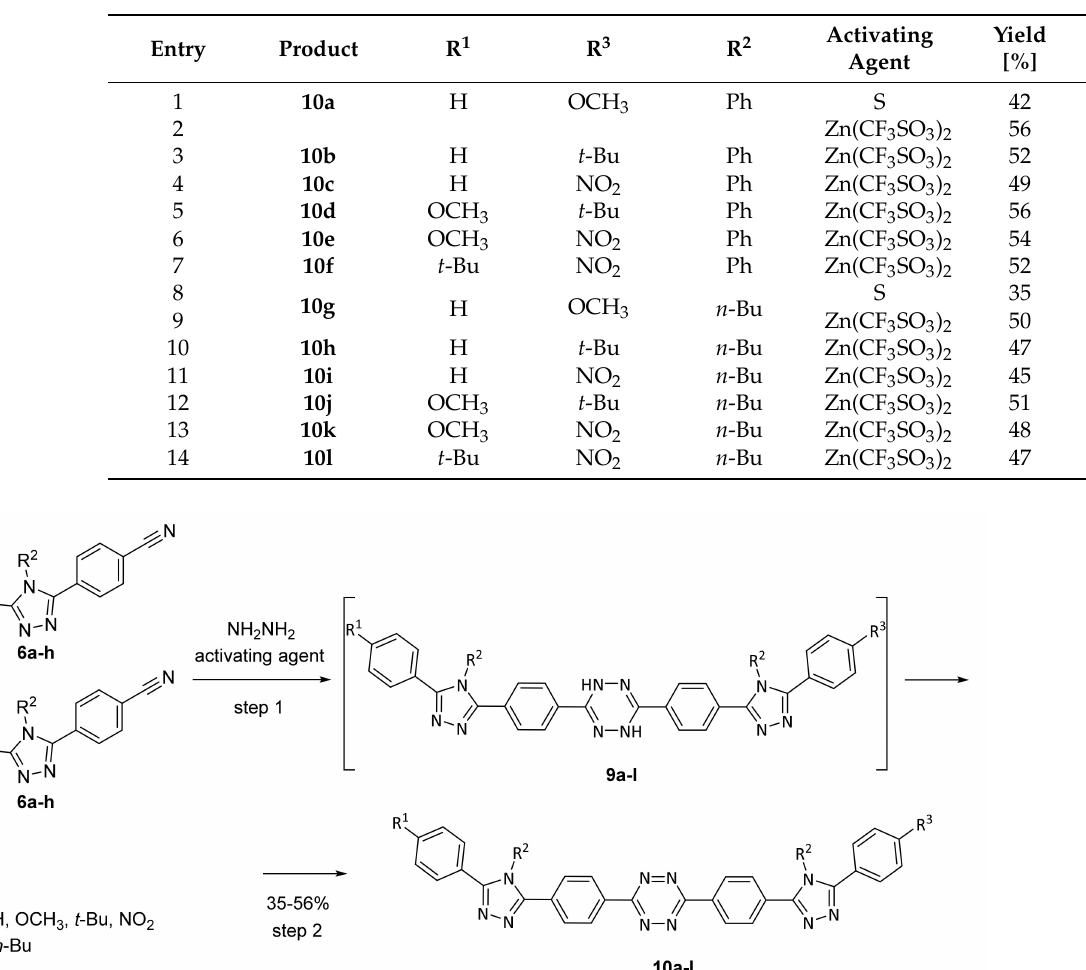
Table 1. The yield of the reaction for the preparation of s -tetrazine derivatives conjugated via a 1,4-phenylene linker with a 4 H -1,2,4-triazole ring ( 10a–l